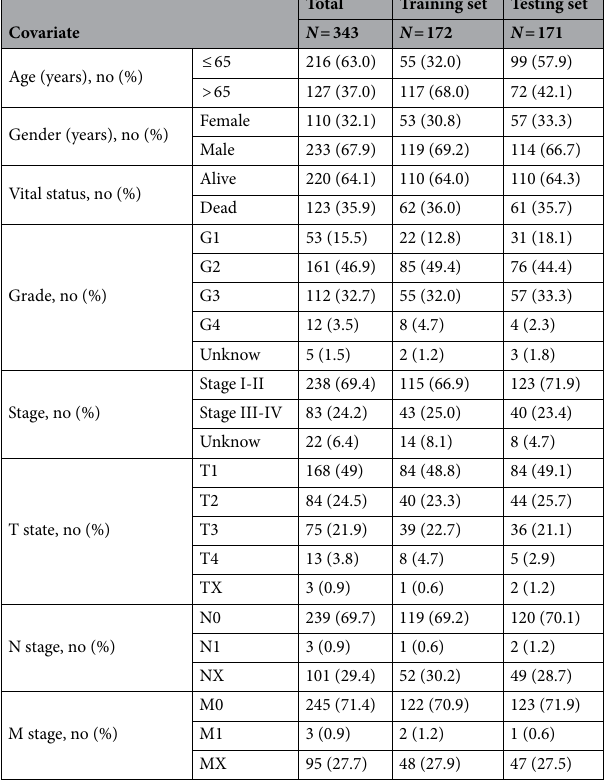
Table 2. Patients’ clinical features of training set and testing